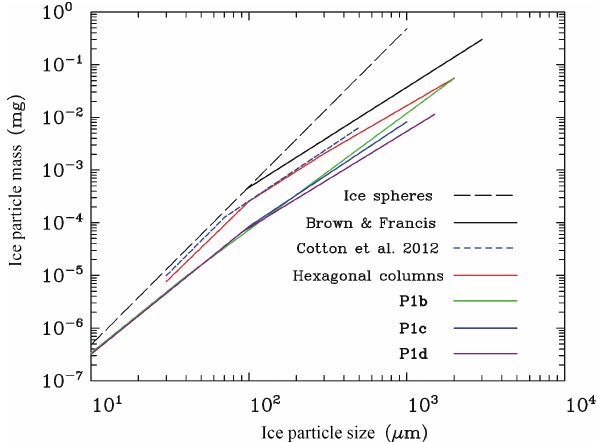
Figure 1. Dependence of ice particle mass ( m) on ice particle max- imum dimension ( D) , based on a variety of power law relationships in the literature (see text for details). Ice spheres indicate an upper limit for m at a given D . P1b, P1c, and P1d denote planar crys- tals with sector-like branches, broad branches, and stellar dendrites, respectively, as described in Mitchell